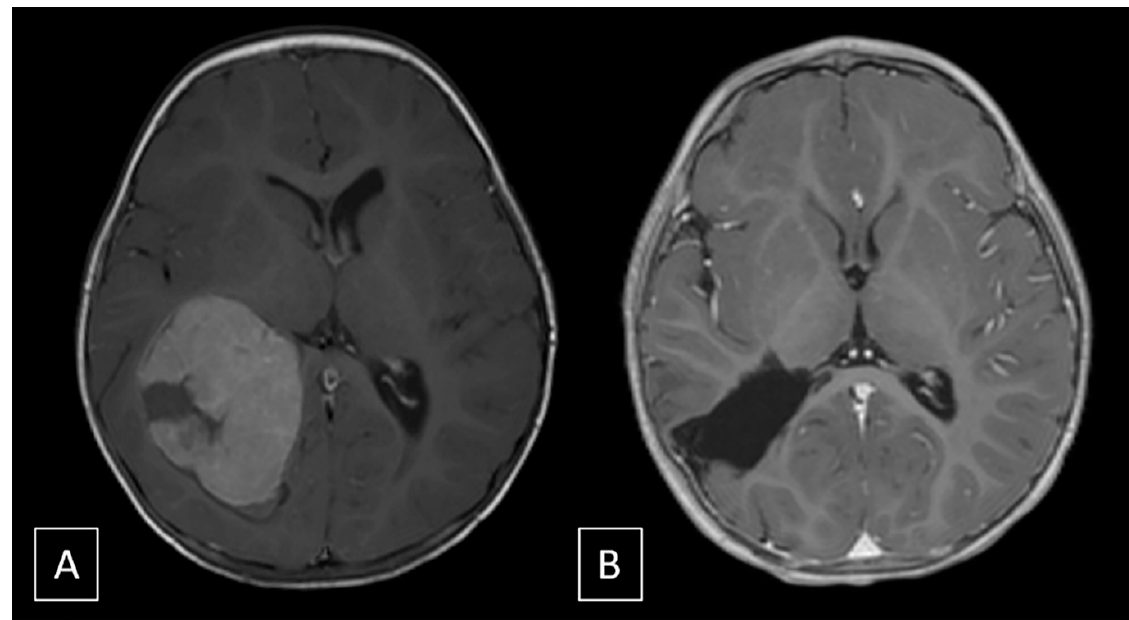
Figure 3. ( A ) T1 post ‐ contrast image pre ‐ operative shows a large enhancing intraventricular mass without invasion of the adjacent brain parenchyma. ( B ) T1 post ‐ contrast image at 3 ‐ months follow ‐ up shows absence of recurrence.